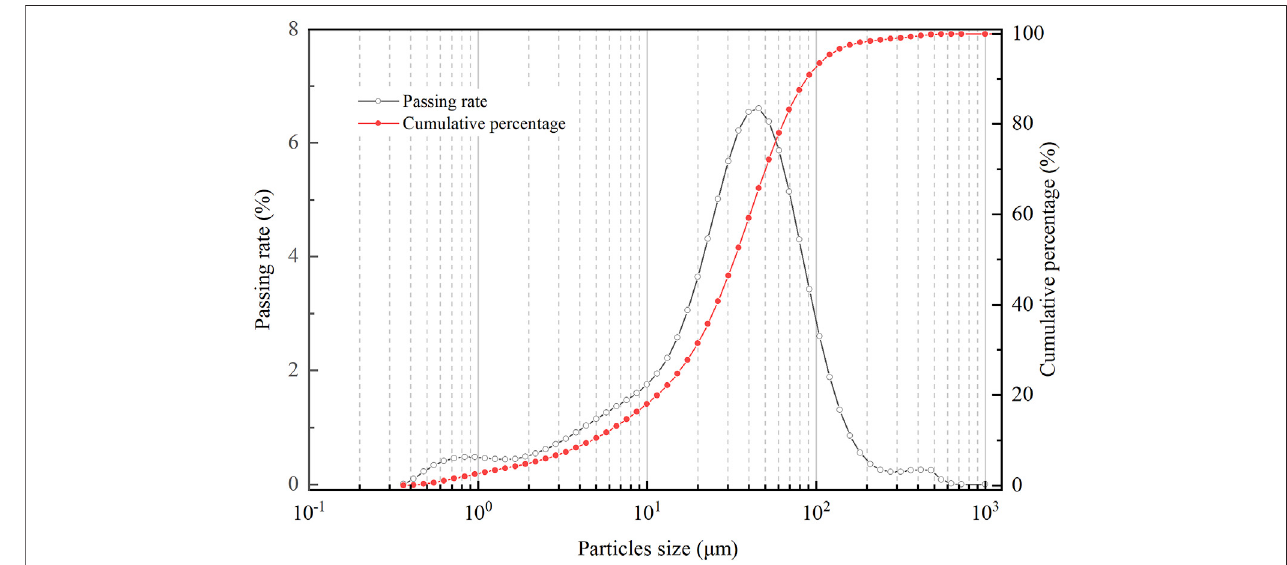
FIGURE 2 | Particle-size distribution curves of